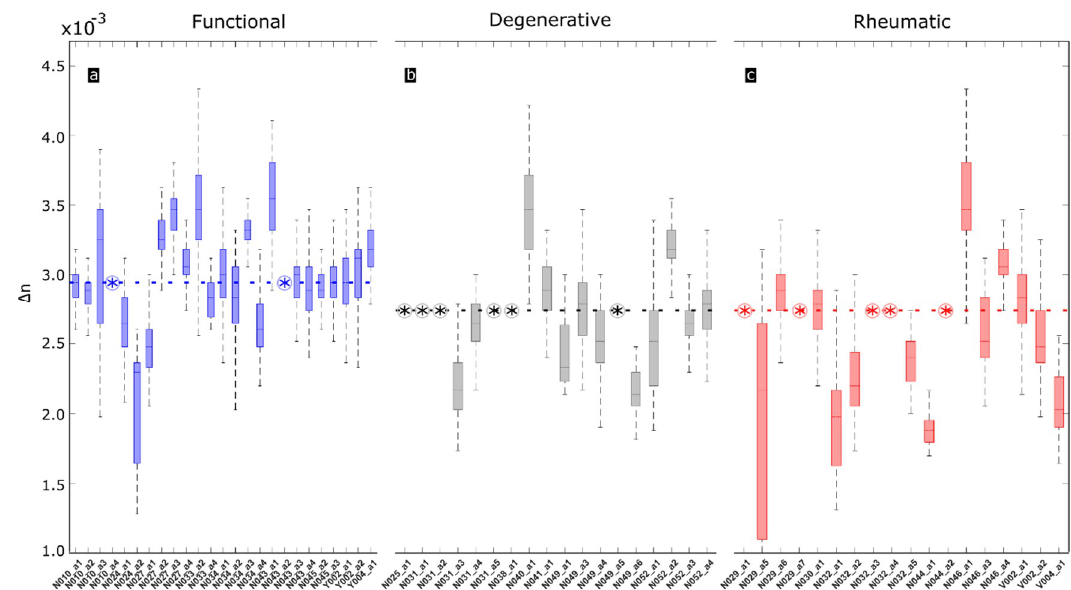
Figure 6. Boxplots representing birefringence value along individual CT specimens of the three categories: functional (blue), degenerative (grey) and rheumatic (red). Dashed horizontal lines represent median of each category. Encircled asterisks represent samples without birefringence. Boxes represent variation within 25% to 75% percentile. Black lines represent 5% to 95% of observations. Horizontal labels represent individual specimens accounting for number of patient (N) and number of chord (a).